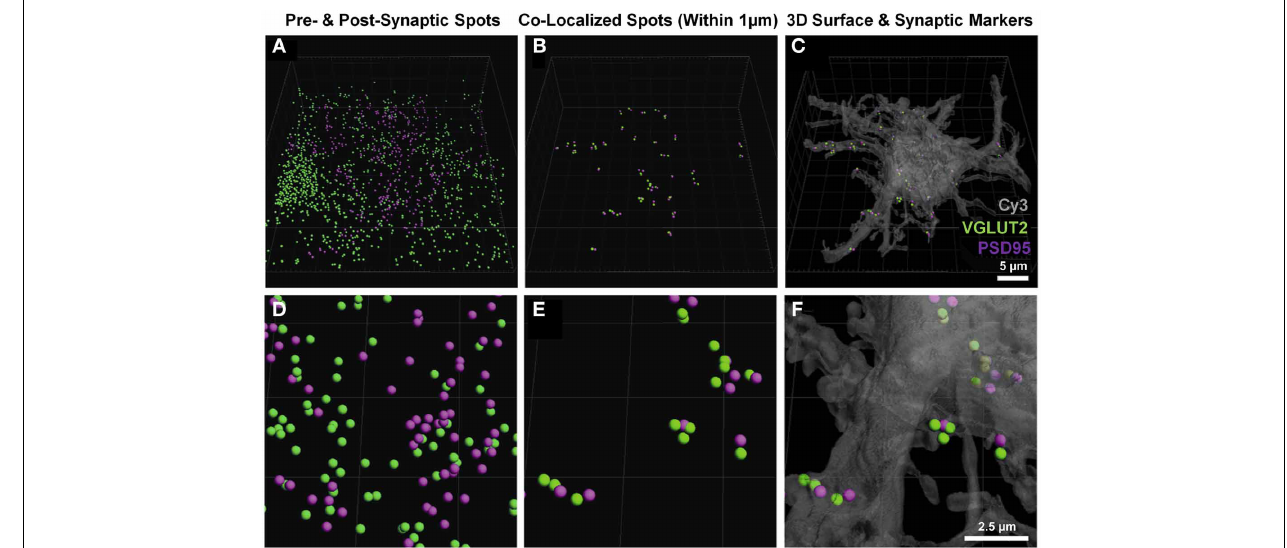
FIGURE 3 | Pre- and post-synaptic localizations to the motor neuron. (A,D ) show the pre-synaptic VGLUT2 (green) and post-synaptic PSD-95 (purple) Imaris-generated “spots” from the neuronal surface masked fluorescence in Figure 2 . (B,E) show these spots co-localized to within 1 μ m using the “co-localize spots” algorithm in Imaris. As all of the post-synaptic